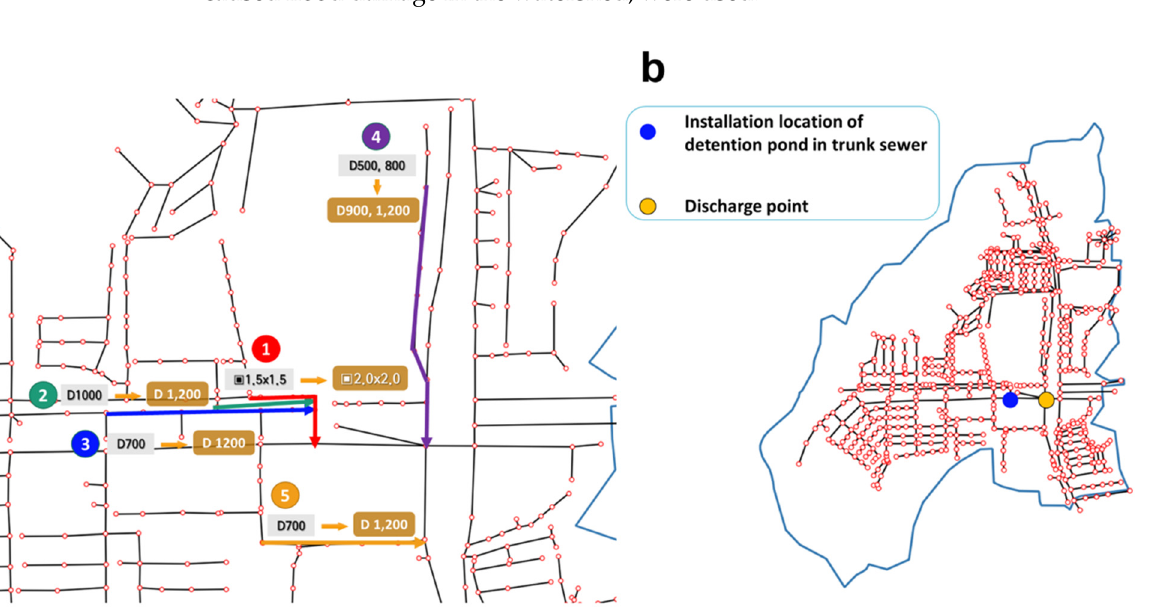
Figure 15. Installation conditions for the reduction facilities in the Dowon watershed. ( a ) Conduit improvement plan and ( b ) trunk drainage sewer.